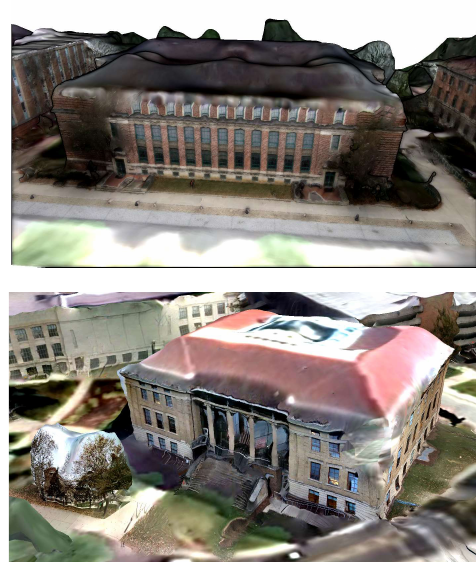
Figure 14. Our multi-source texture mapping method applied on the generated surface model.